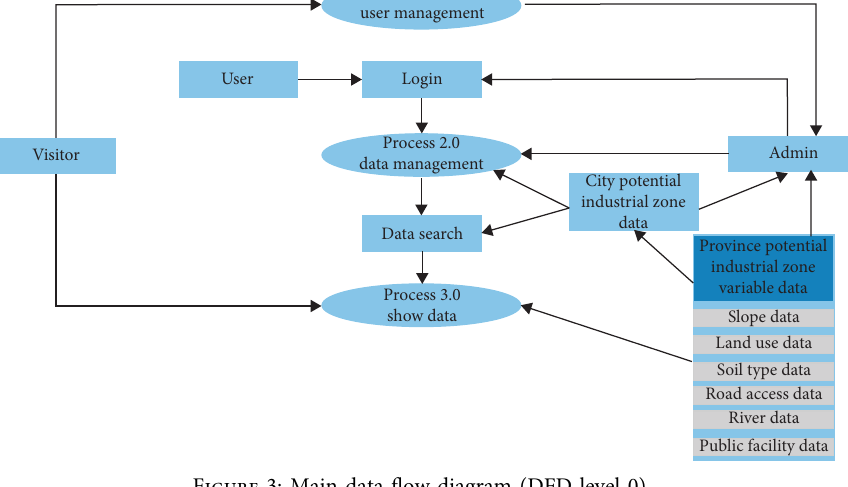
Figure 3: Main data flow diagram (DFD level